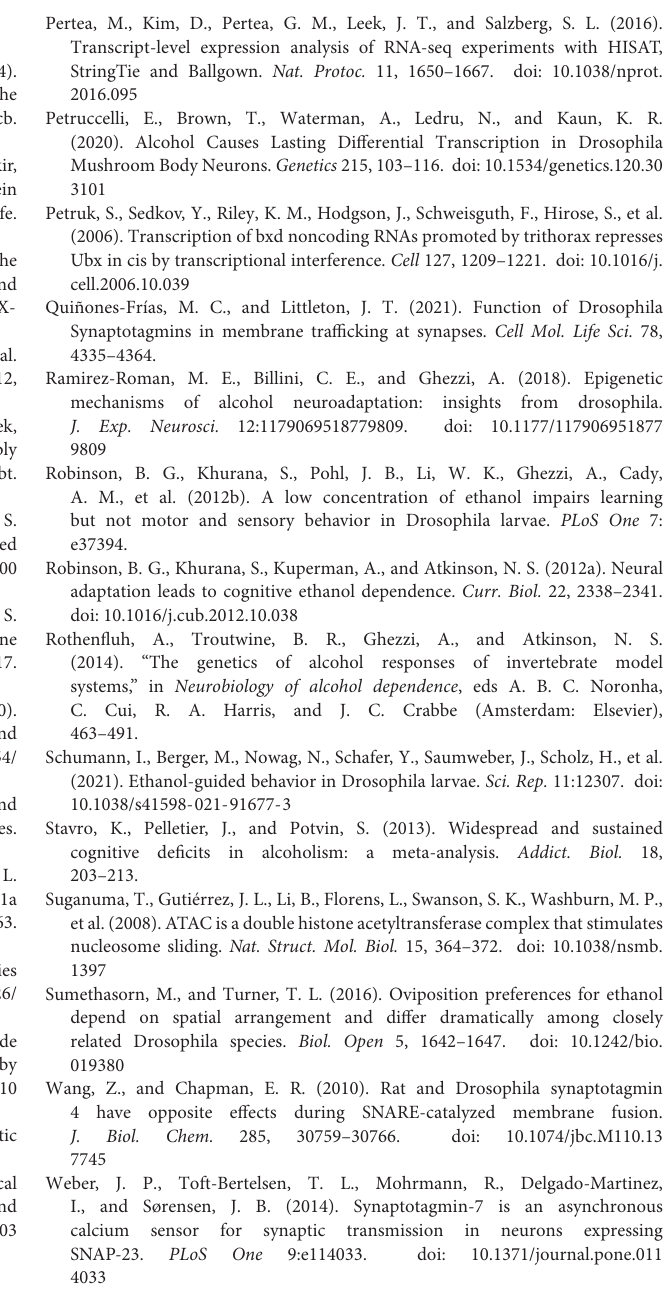
Supplementary Table 1 | Complete annotated list of differentially expressed transcripts after chronic alcohol exposure. Supplementary Table 2 | Complete FPKM counts for each replicate